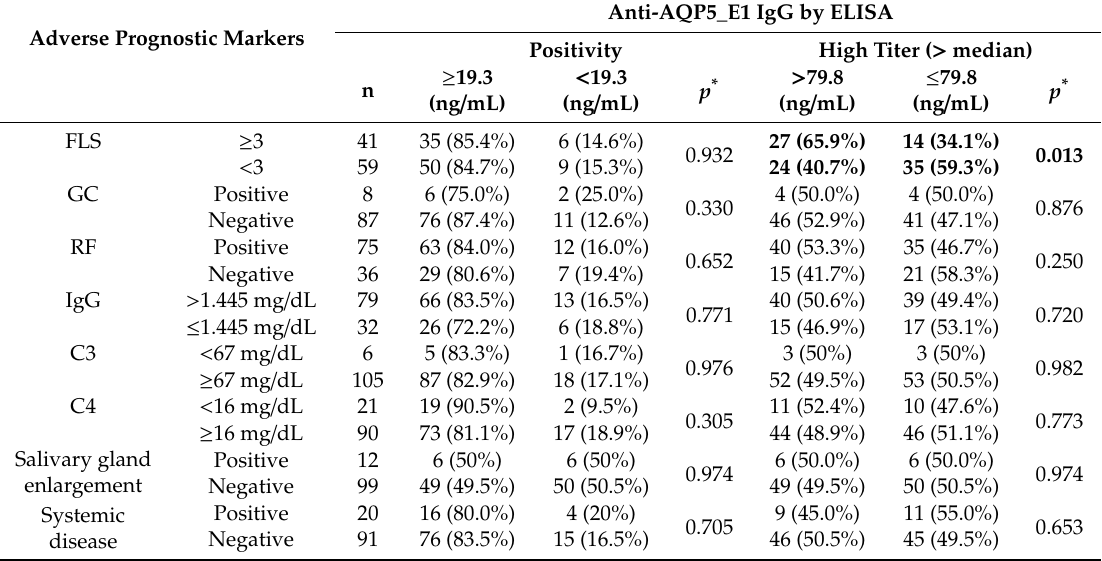
FLS: focal lymphocytic sialadenitis; GC: germinal center; RF: rheumatoid factor. *By either chi-square or Fisher’s exact test. Bold denotes statistical significance at p < 0.05 .